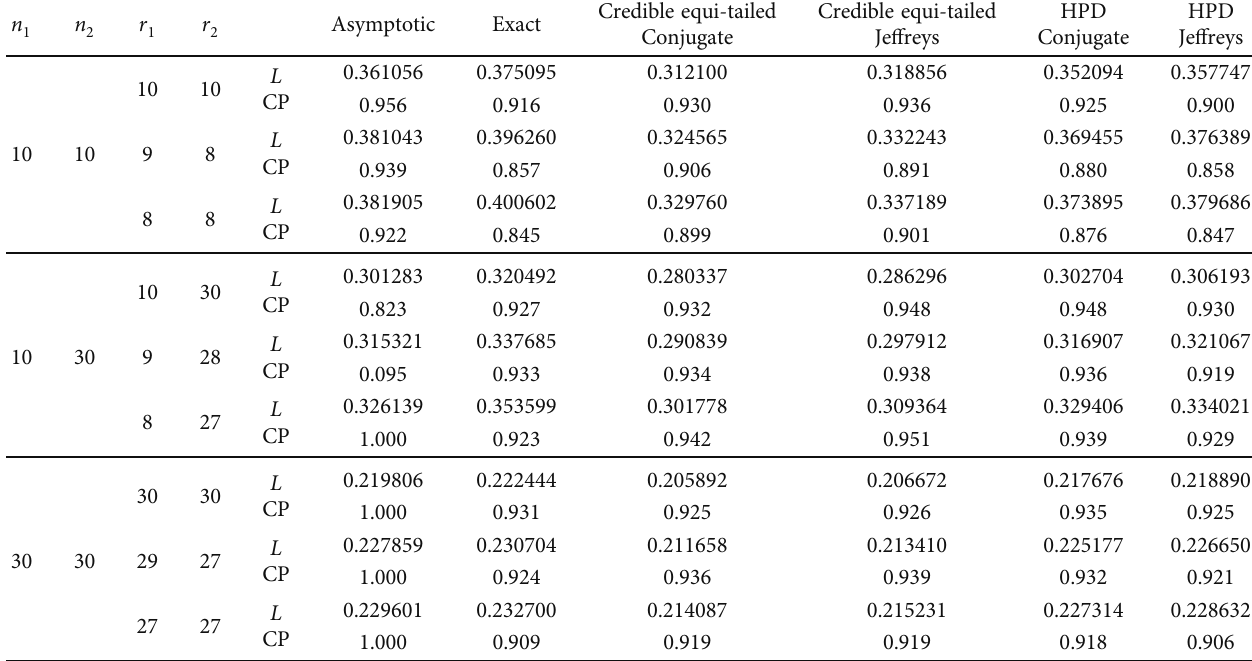
= 2, β = 1 and γ = 1 1 2